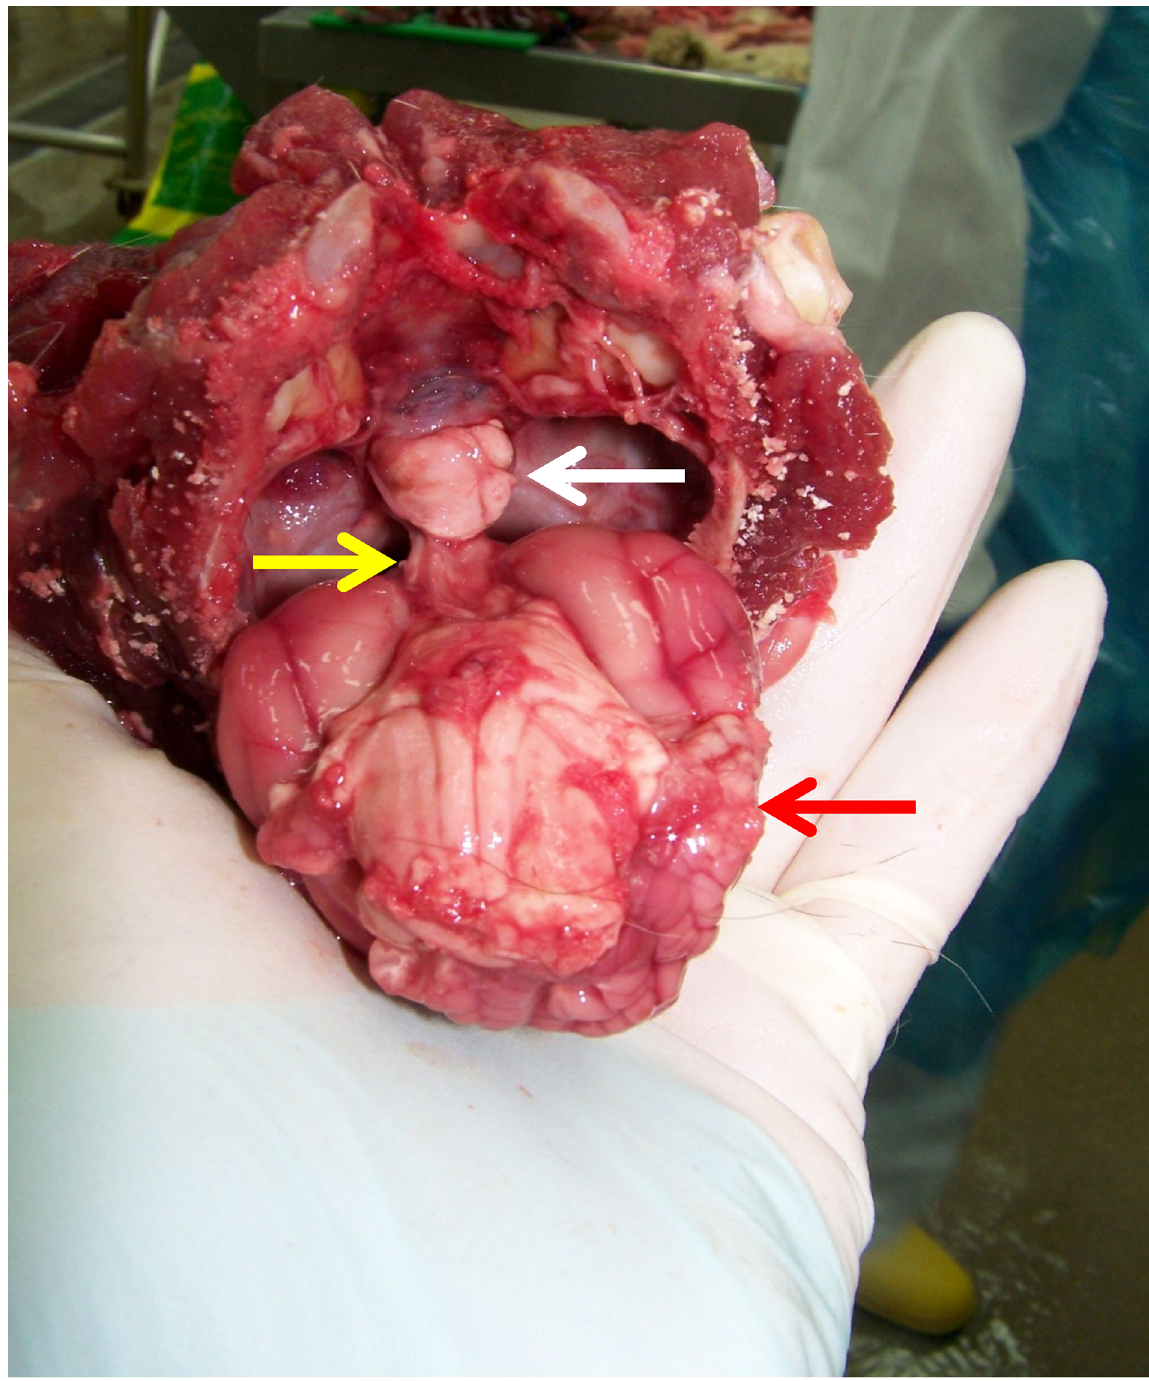
Fig 8. Macroscopic necropsy picture of the brain of a diabetic cat with confirmed HS. This picture shows the ventral aspect of the brain of a cat with HS as it was removed from the cranial cavity and a clearly enlarged pituitary falling out of the sella turcica (cranium is held upside down; white arrow: pituitary gland; yellow arrow: pituitary stalk; red arrow: cerebrum). Histopathology confirmed the presence of an acidophilic macroadenoma.